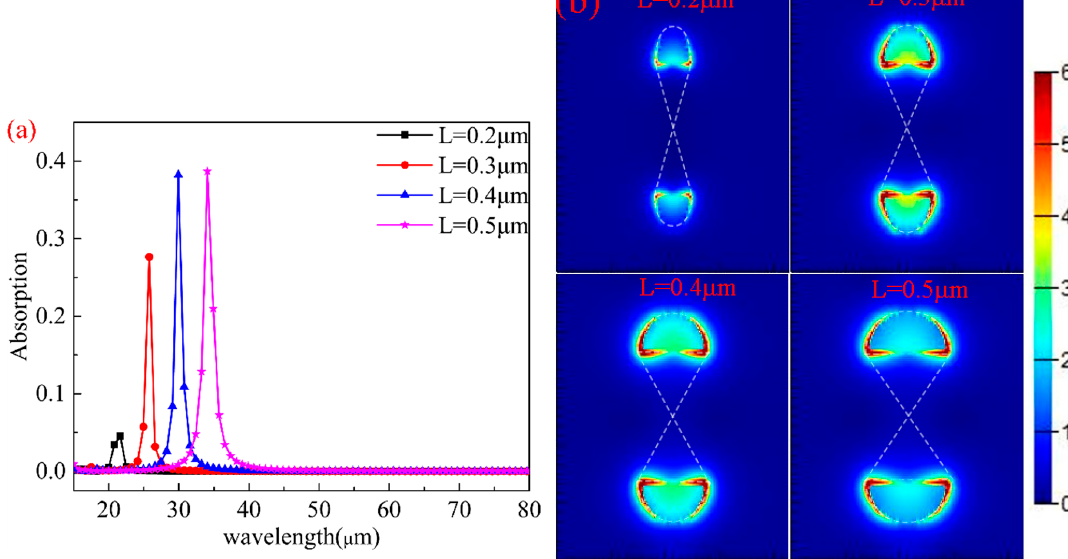
Figure 5. ( a ) The absorption spectra of the structure with different L values. ( b ) The electric field distributions at the maximum absorption for L = 0.2,0.3,0.4,0.5 µ